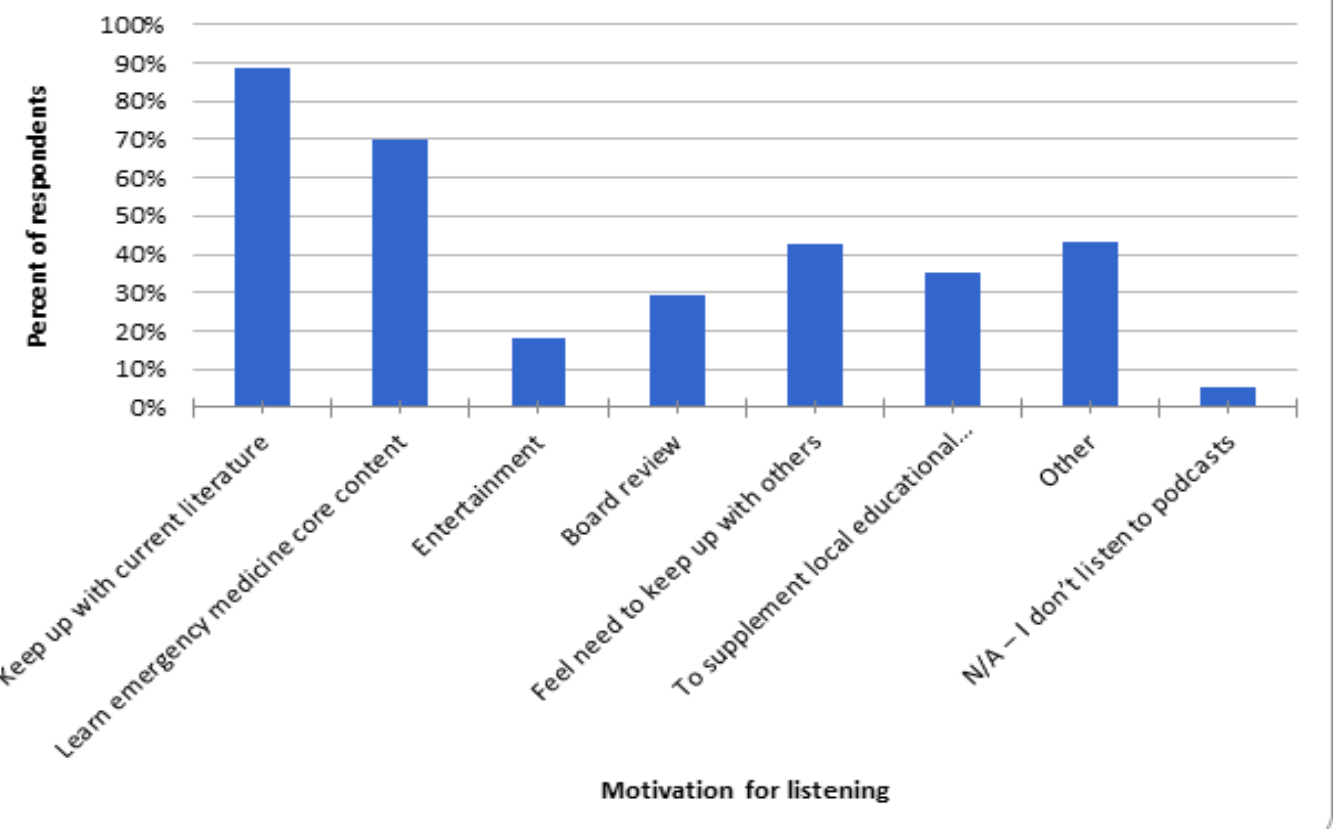
Figure 2. Residents’ motivation for listening to emergency medicine